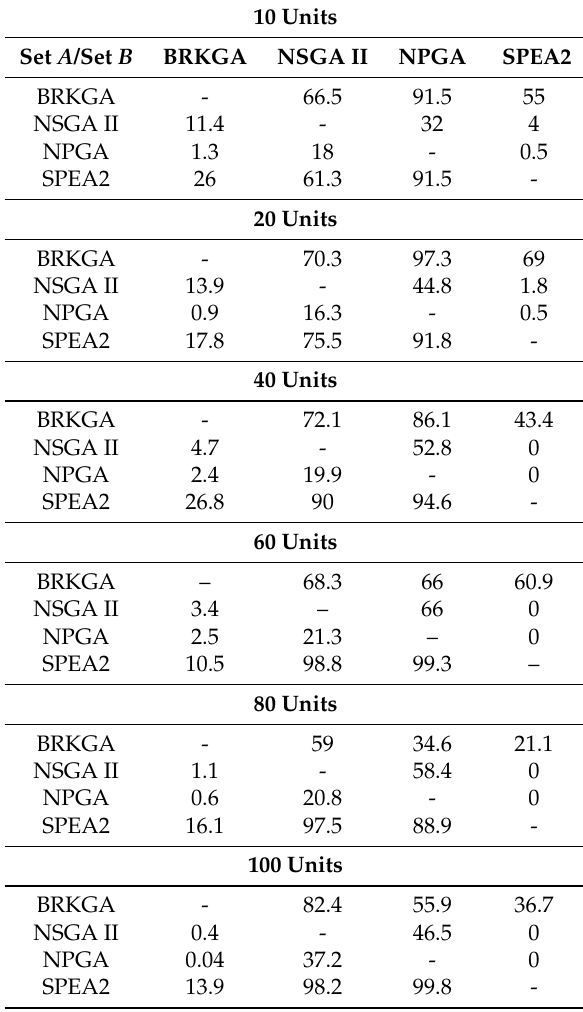
Table 8. Percentage of Non-dominated Solutions of set B covered by those in set A .